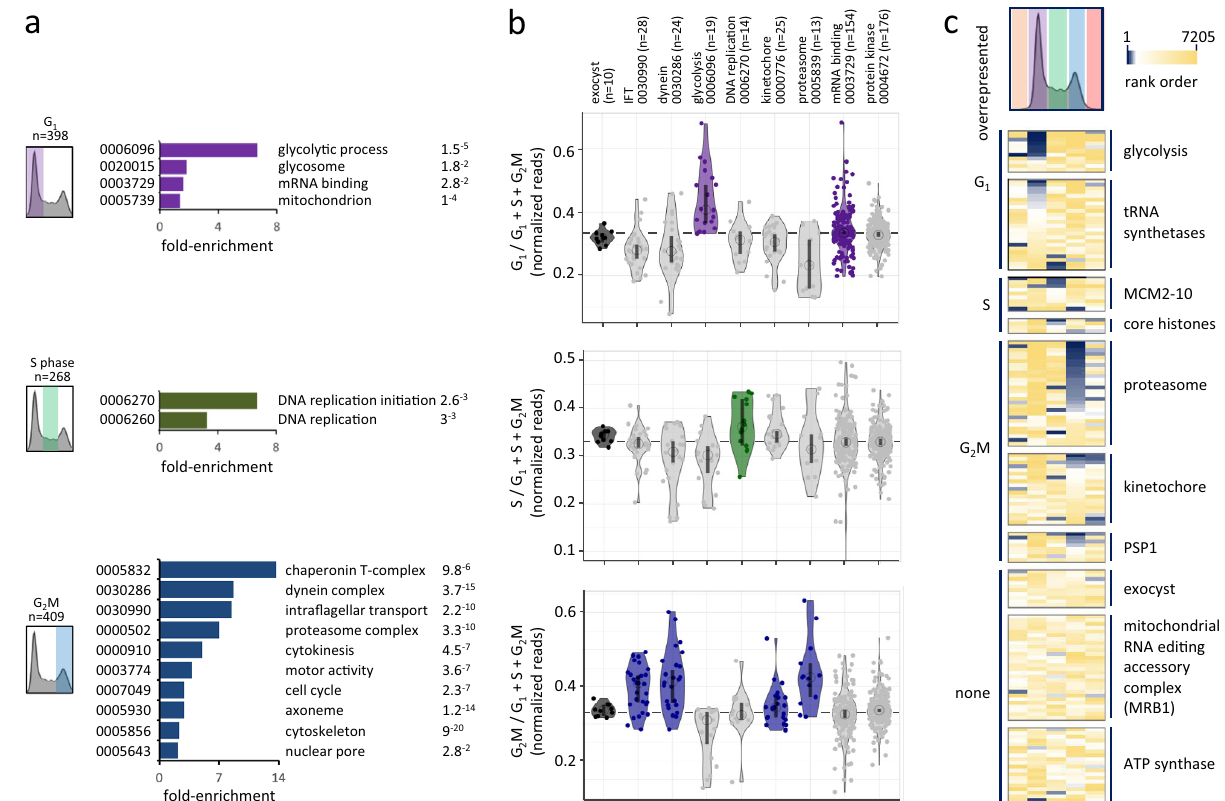
Fig. 4 | A pro fi leofG 1 , S phase and G 2 M defects.a The bar-graphs show enriched GeneOntologytermsassociatedwiththeG 1 ,SphaseorG 2 Mhits,thosethatregister >25% overrepresented read-count in each of these categories. P -values are shown on the right. b The violin plots show relative G 1 , S phase or G 2 M read-counts for cohorts of genes and re fl ect data distribution. Opencircles indicate medianvalues